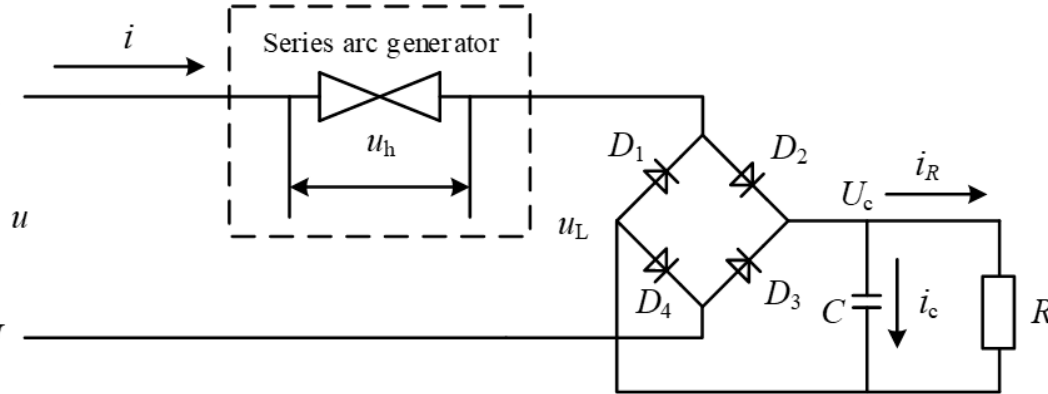
Figure 5. Test circuit of diode rectifier with capacitive filter without an electromagnetic interference (EMI) filter.